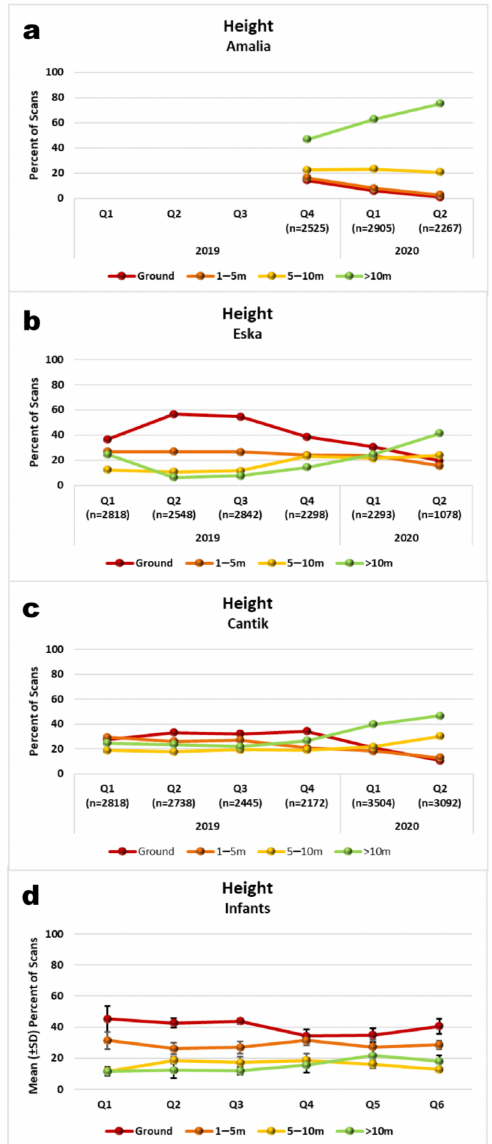
Figure 9. Use of forest stratum by individual juveniles ( a – c ) and means across all four infants ( d ). Amalia was high up in the trees, in 10 m or more most of the time (mean across Q4–Q6: 62%). By comparison, Eska was still roughly 40% of the time on the ground (mean across Q1 to Q6). However, Figure 9a–c and Table S3 indicate a steady decrease of time on the ground for all juveniles, including Eska, from Q4 onward. By Q6, all juveniles spend more time above 10 m than on the ground (Figure